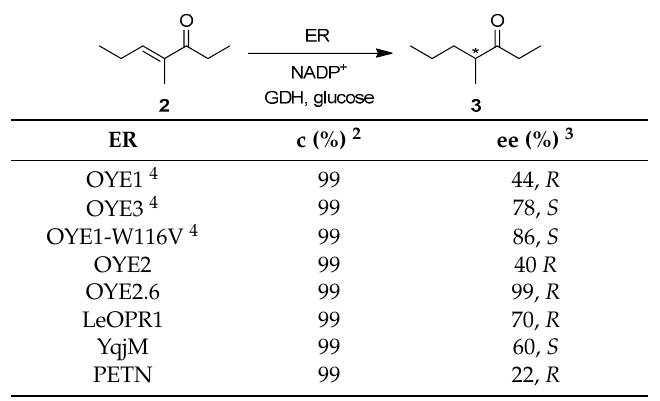
Table 1. Ene-reductase-mediated hydrogenation 1 of unsaturated ketone 2 .